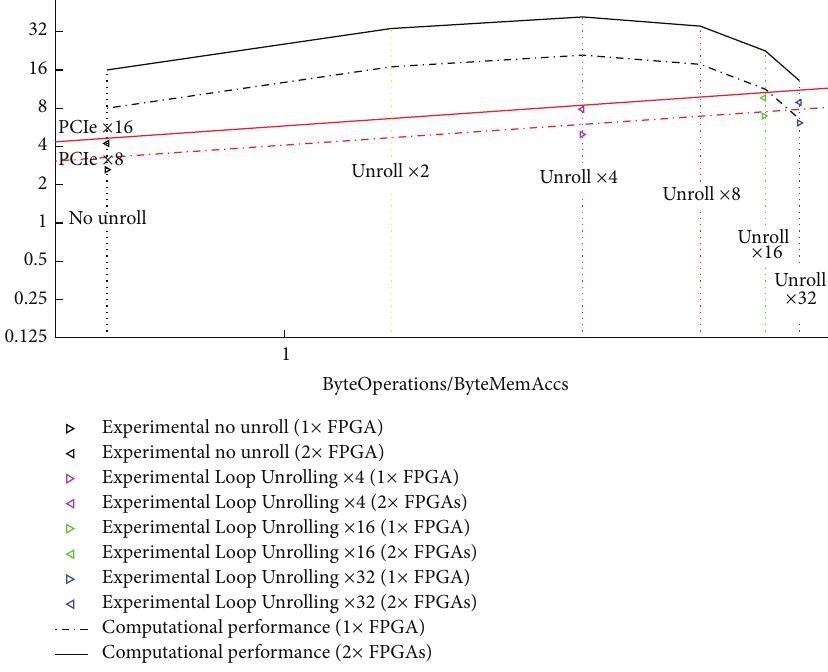
Figure 8: Resultant roofline model of Erosion using Vivado HLS and for multiple FPGAs. The experimental results depicted have been obtained with the pipelining design operating at